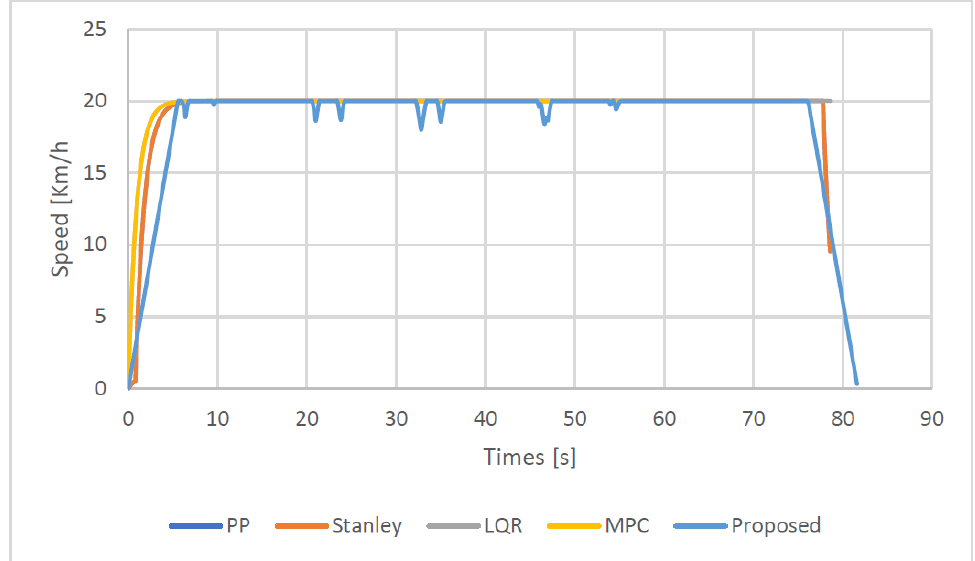
Figure 14. Speed comparison of the different trajectory tracking controllers.